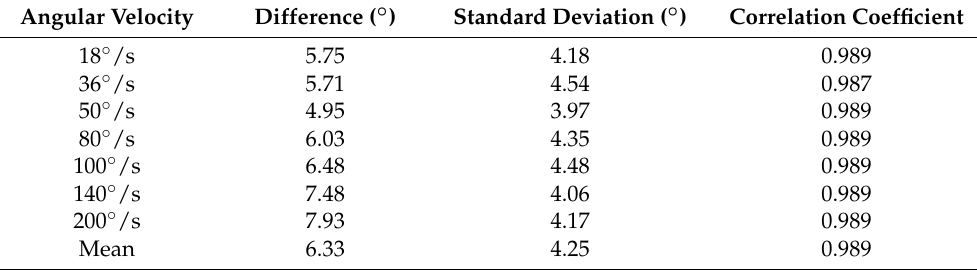
Table 1. Experimental results for dynamic tests realized in a test